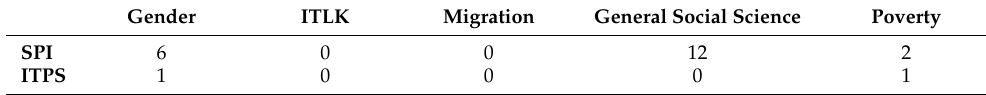
Table 4. Co-occurrences between ‘land tenure’ and other